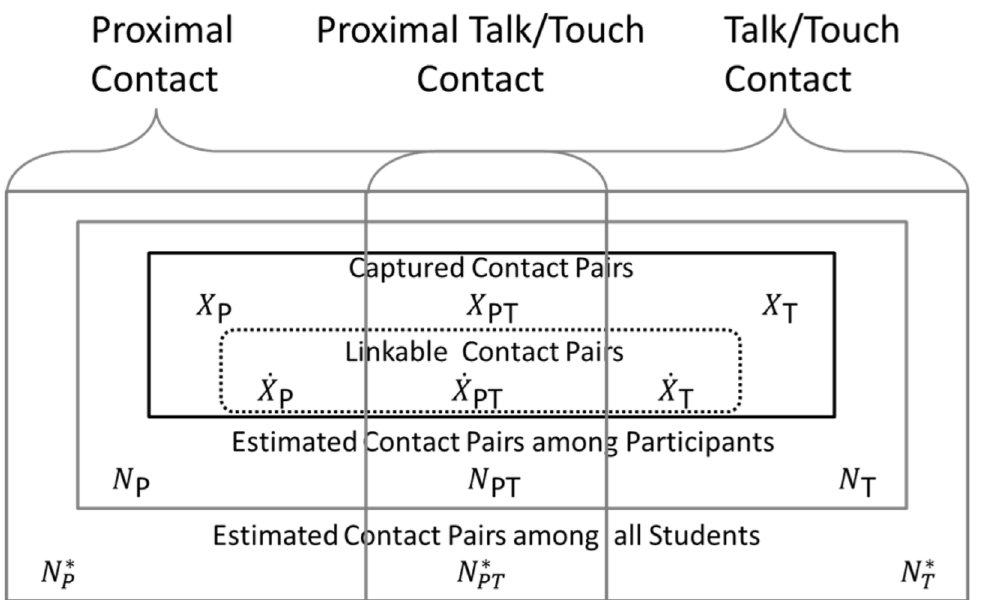
Fig 2. Framework and notation for enumeration of contact pairs. Contact pairs are either proximal only, proximal talk/touch, or talk/touch only. The linkable data set is a subset of the captured contact pairs. We observe the quantity ( X P + X PT )as the total WREN contacts and ( X T + X PT ) as the total Log contacts.